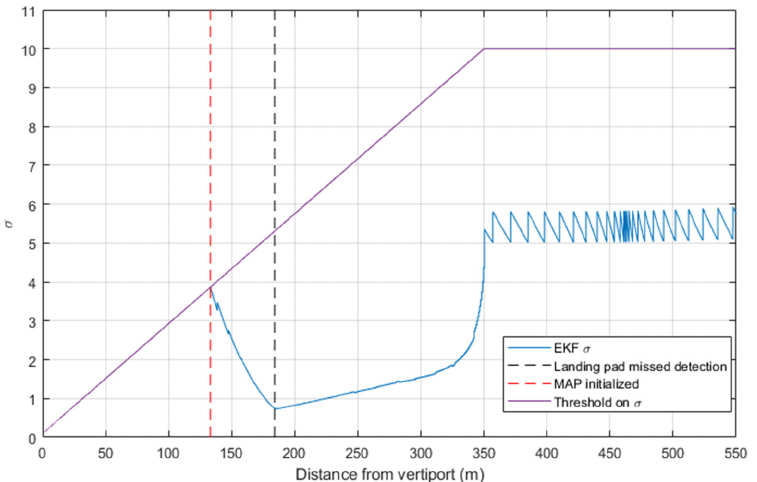
Figure 22. Three-dimensional positioning uncertainty as extracted from the EKF covariance matrix in function of the distance from the landing pad in case of VTCA trajectory with a local fog bank which precludes landing pad visibility at 184 m distance from it. The MAP is autonomously initial- ized at 135 m.